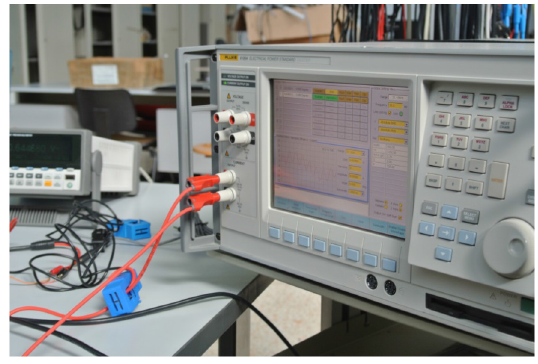
Figure 2. The SCT-013-030 during the calibration phase.